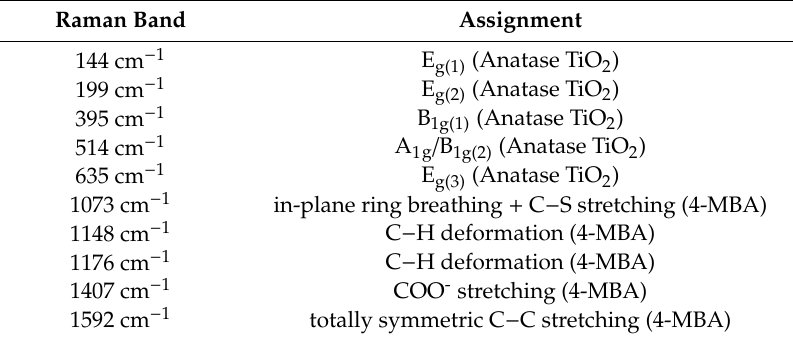
Table 1. Raman bands and assignments of 4-MBA-modified